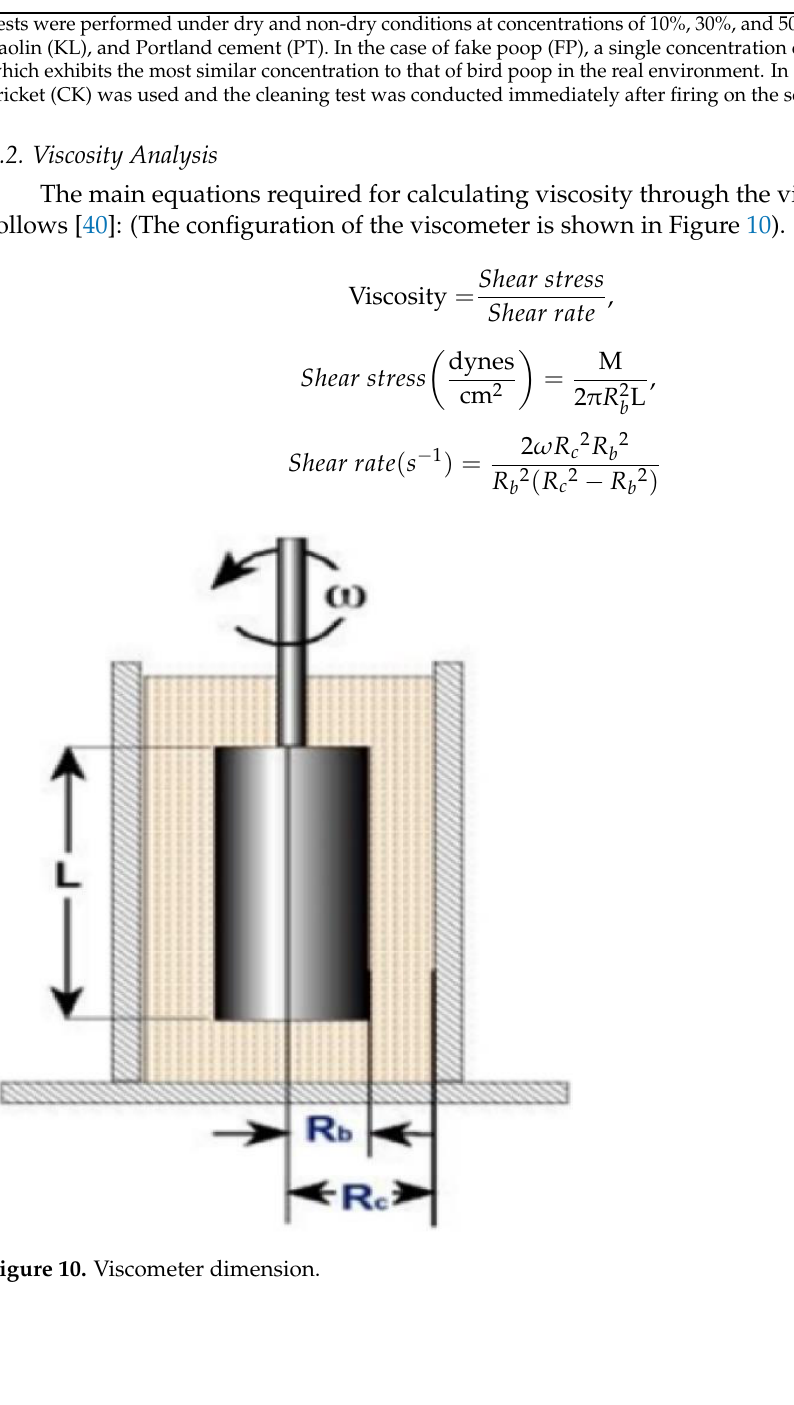
Table 4. Viscosity value measurement variable, spindle specification. Variable